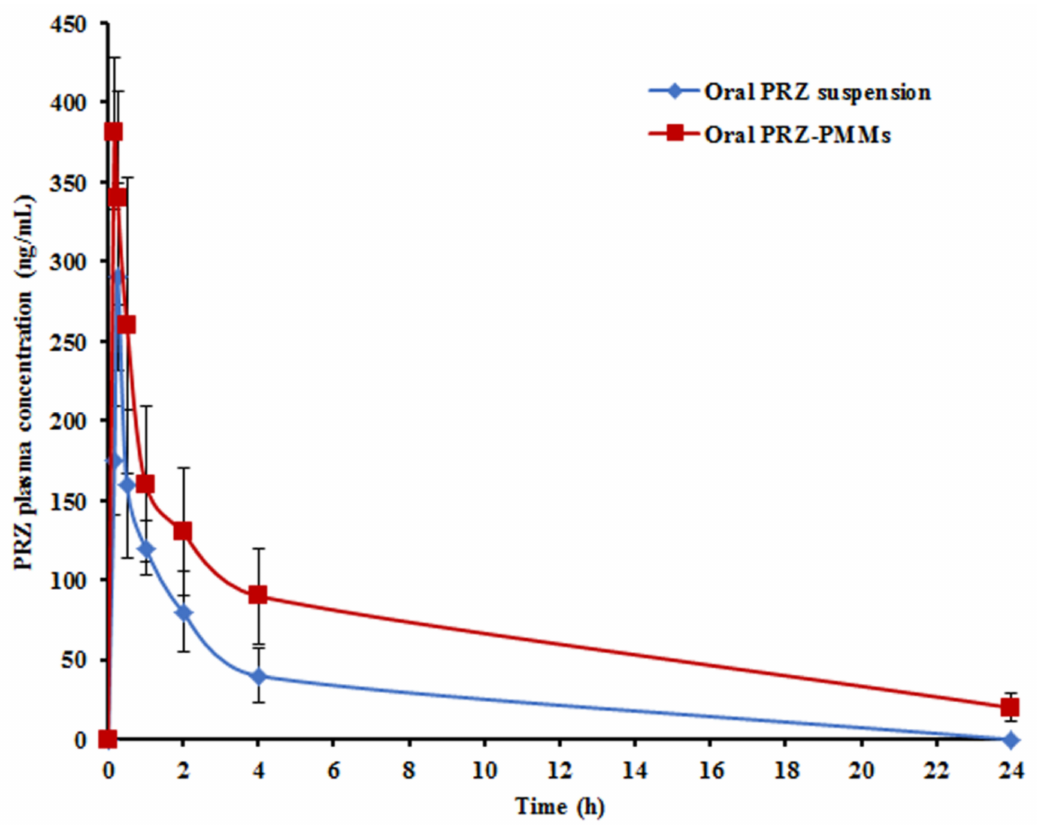
Figure 8. Mean PRZ plasma concentrations in rats after oral administration of the optimum micellar formulation and drug suspension ( n =